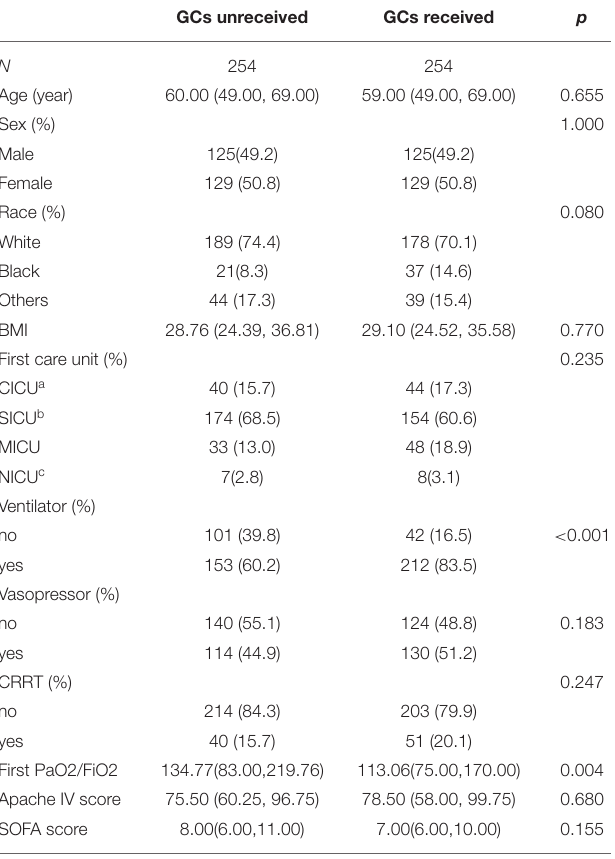
TABLE 1 | Baseline characteristics between GCs unreceived/received